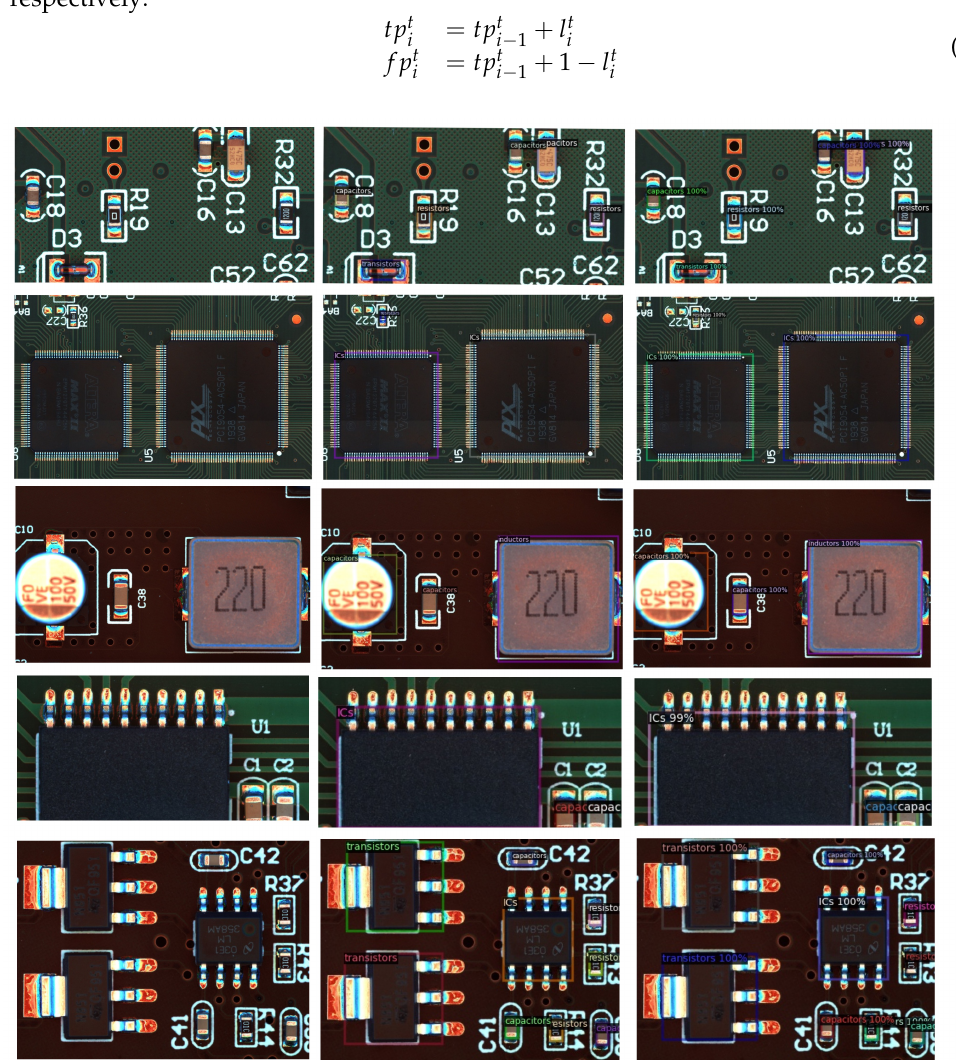
Figure 10. Experimental results of our method. ( left ) Raw image; ( center ) ground truth; ( right ) result of our